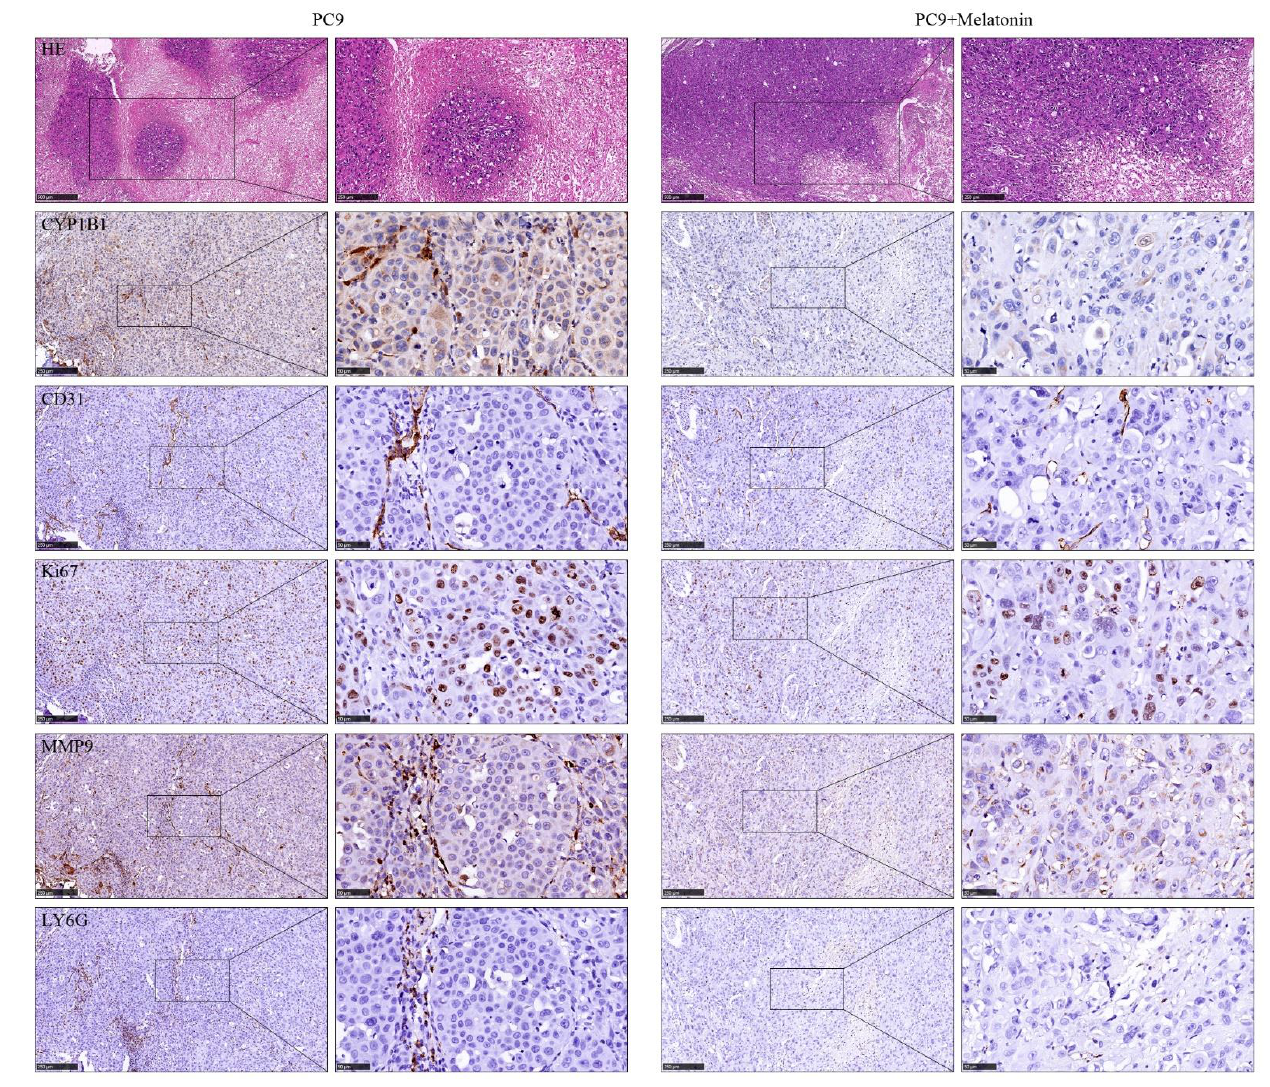
Figure 6. The HE and immunohistochemical staining of CD31, ki67, MMP9, and LY6G between PC9 and PC9 + Melatonin